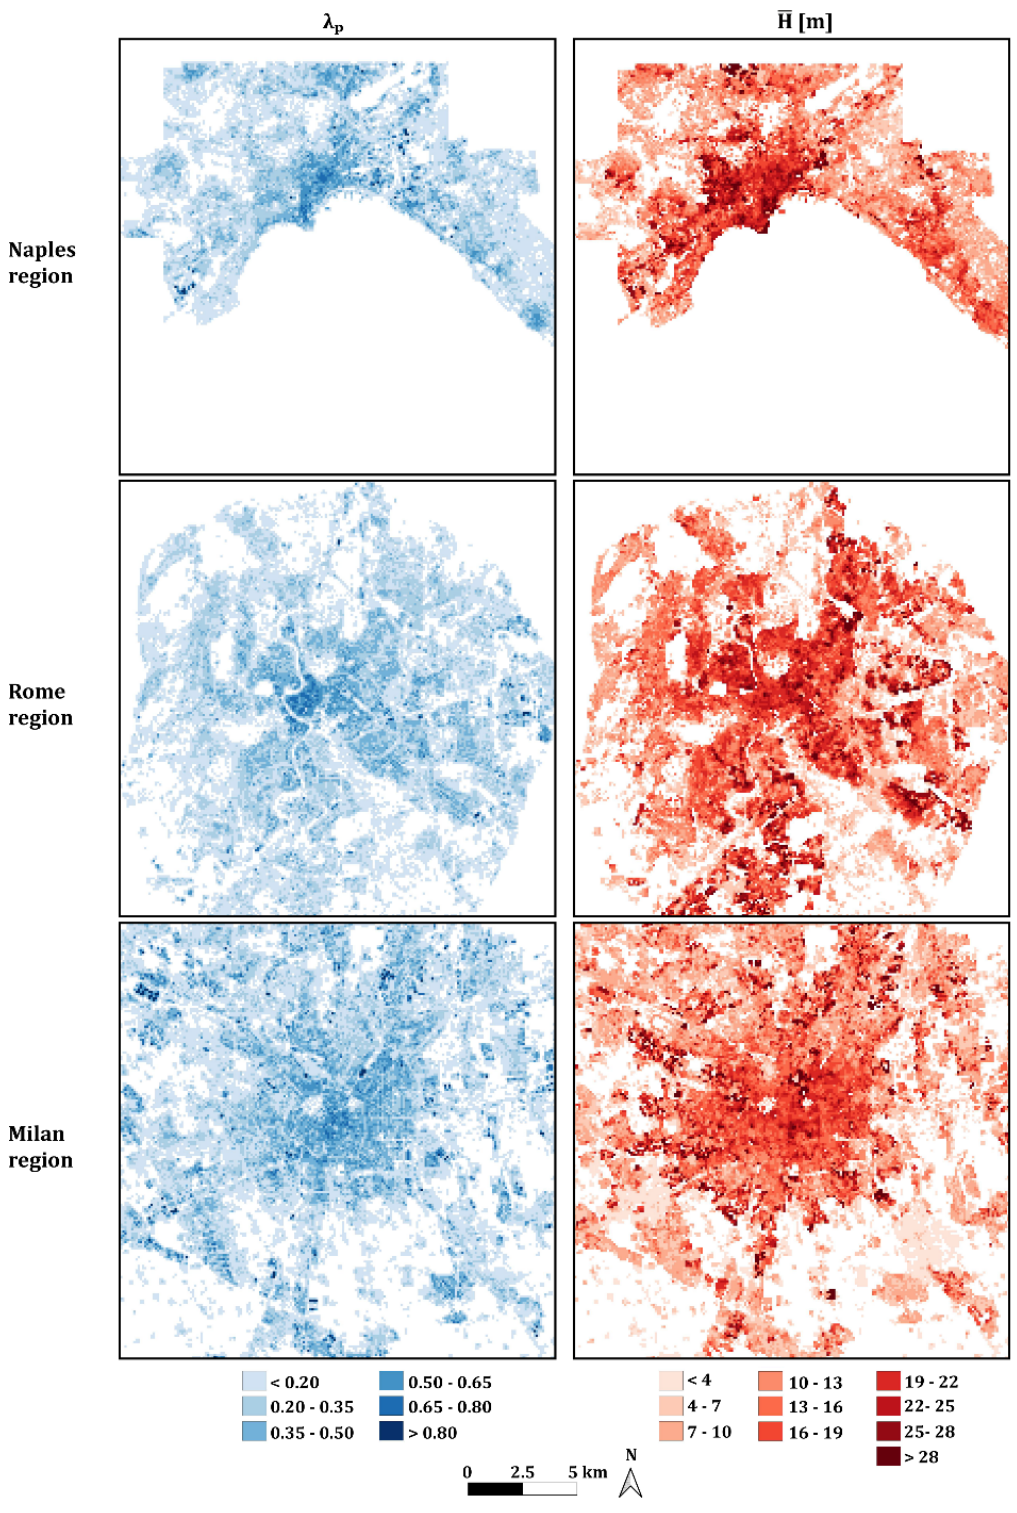
Figure 5. Maps of plan area index, λ p , and mean building height, H , for the Naples, Rome, and Milan regions. Table 1. Spatially ‐ averaged, median and maximum values of the morphological parameters over the whole region.